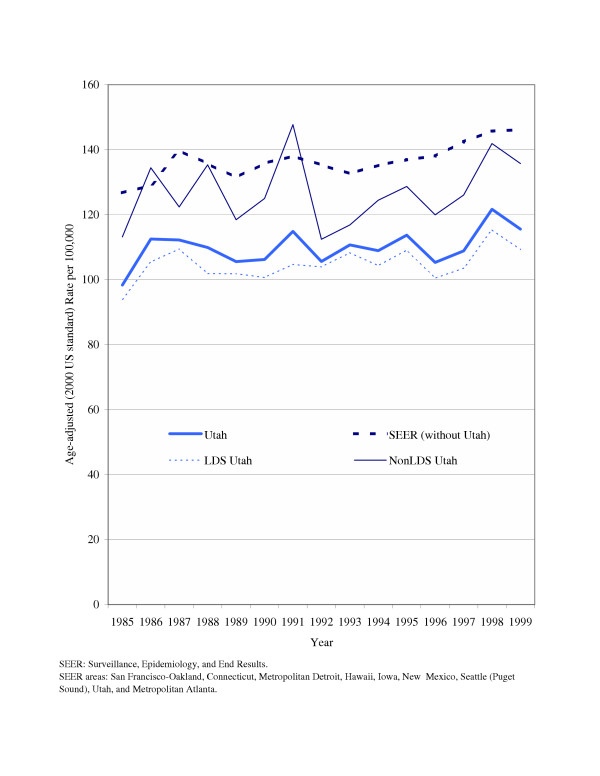
Malignant breast cancer incidence in white women in Utah and SEER (without Utah)